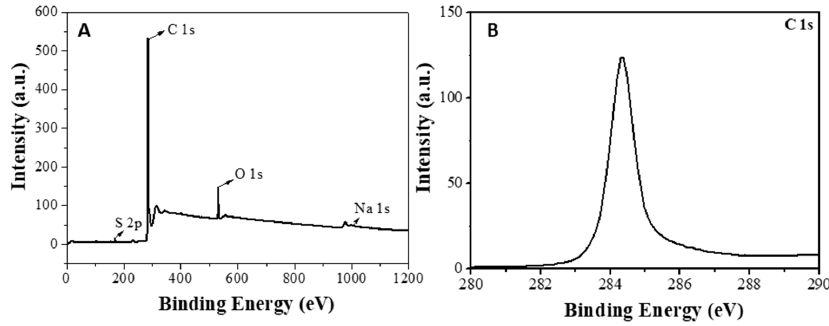
Figure 1. X-ray photoelectron spectra (XPS) of GNPs: ( A ) survey scan and ( B ) C 1s.